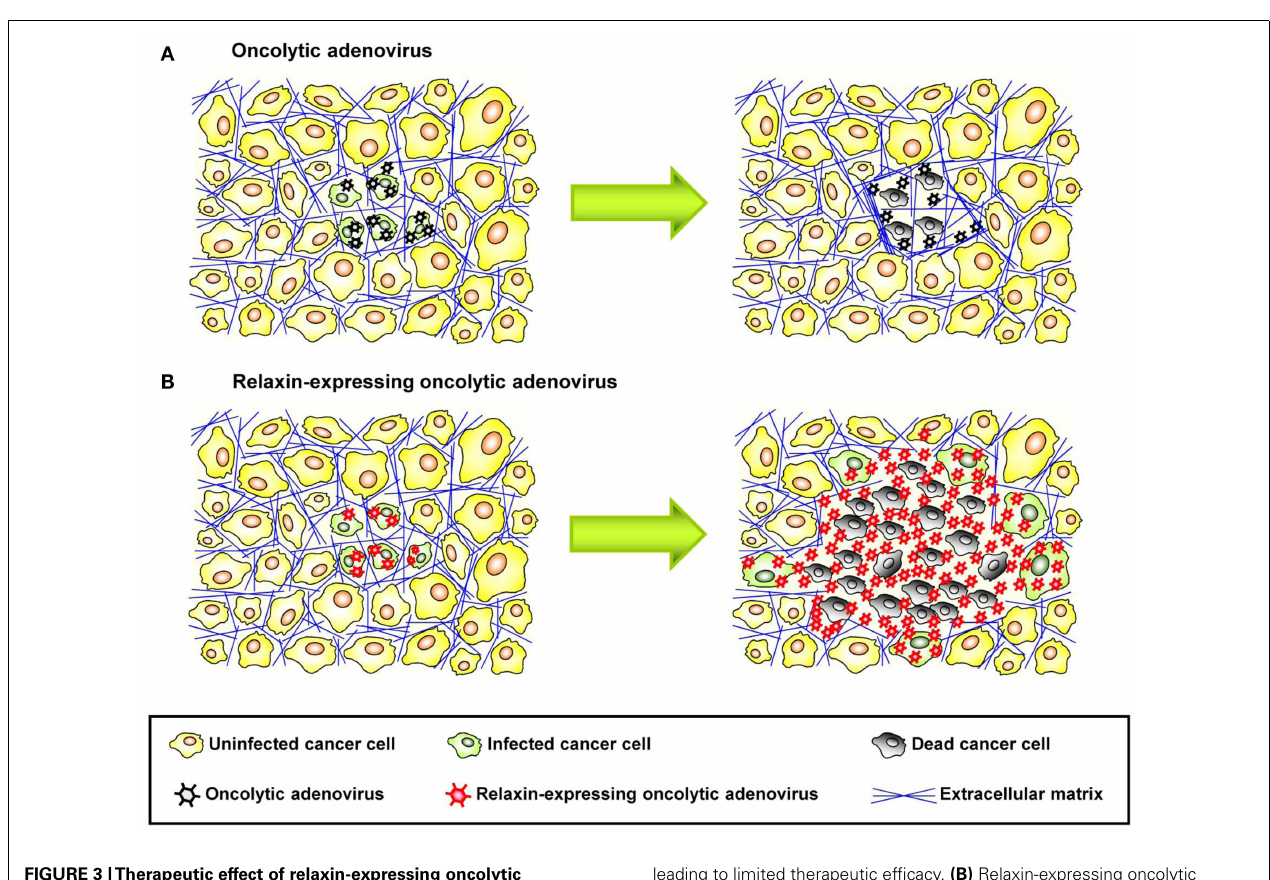
FIGURE 3 |Therapeutic effect of relaxin-expressing oncolytic adenovirus. (A) ECM acts as a physical barrier in solid tumors, so that interstitial viral penetration and cell-to-cell spread of conventional oncolytic adenoviruses is restricted to the site of administration,